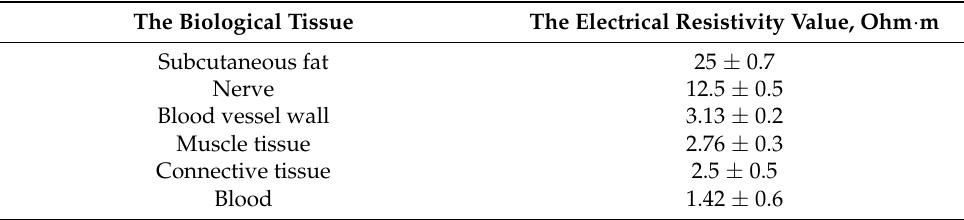
Table 1. The electrical resistivity of forearm biological tissues at 100 kHz frequency.